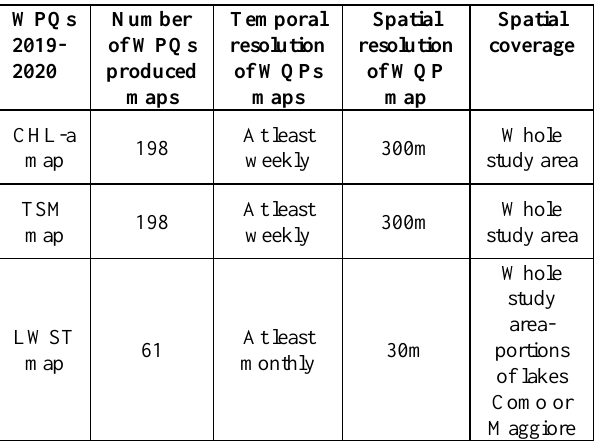
Table 1 . The remotely sensed WQPs maps dataset for